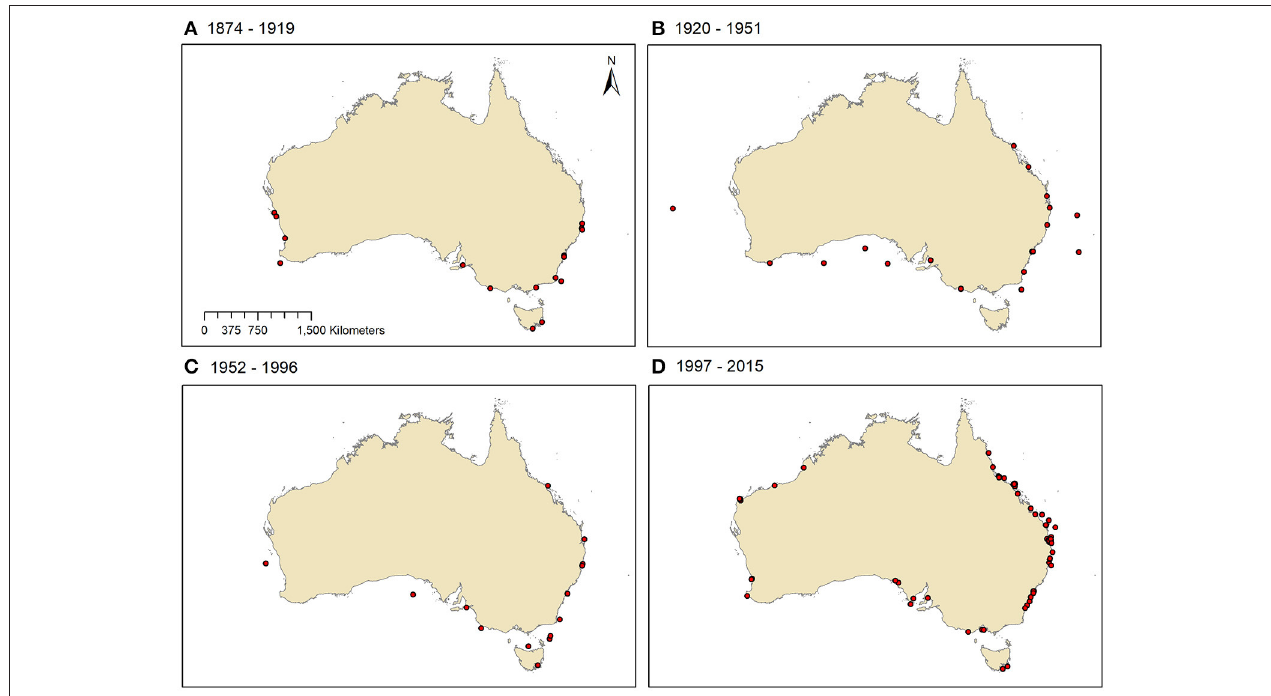
FIGURE 6 | Approximate locations of reported vessel strike collisions and strandings, by period for Australia: (A) 1874–1919; (B) 1920–1951; (C) 1952–1996; and (D)